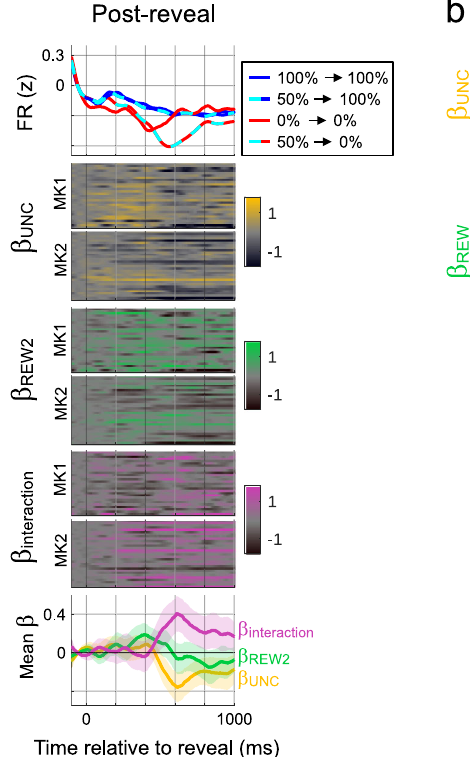
reward and interaction) for each neuron included in the top panel. The bottom panel shows the average coef fi cients (shading shows ±2 SEM). b Lack of anticipa- tion of information on no-reveal trials. The panels show uncertainty and reward coef fi cients on no-reveal trials, aligned on the time of reward onset (mean and ±2 SEM, n =59/68 cells for mask in/outside RF with at least 2 trials in each condi- tion). Source data are provided as a Source Data fi